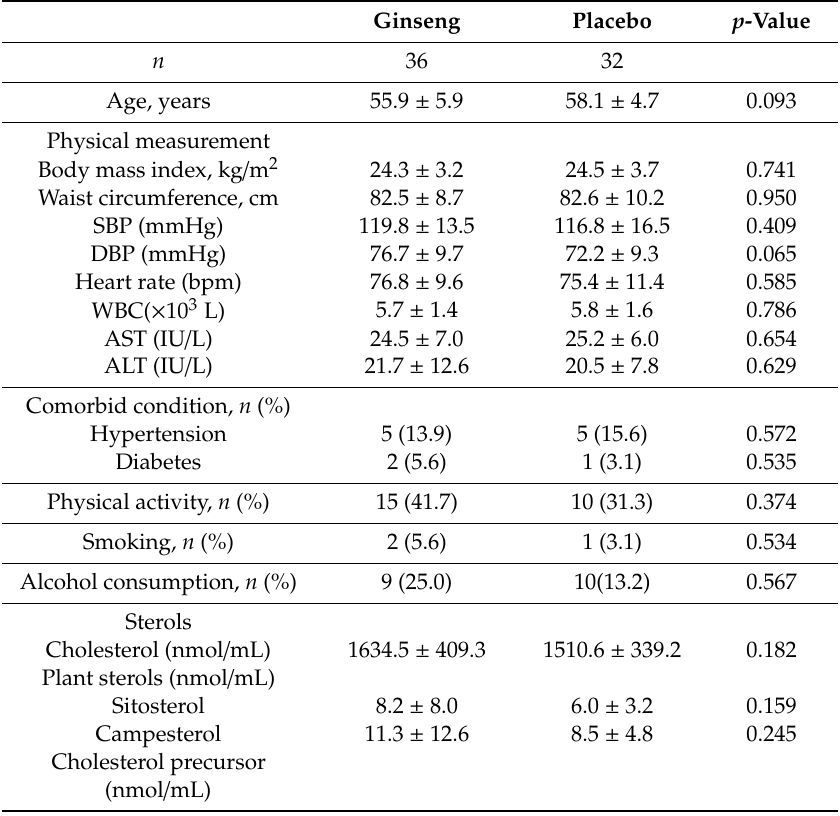
Table 1. Baseline characteristics of the study participants. Ginseng